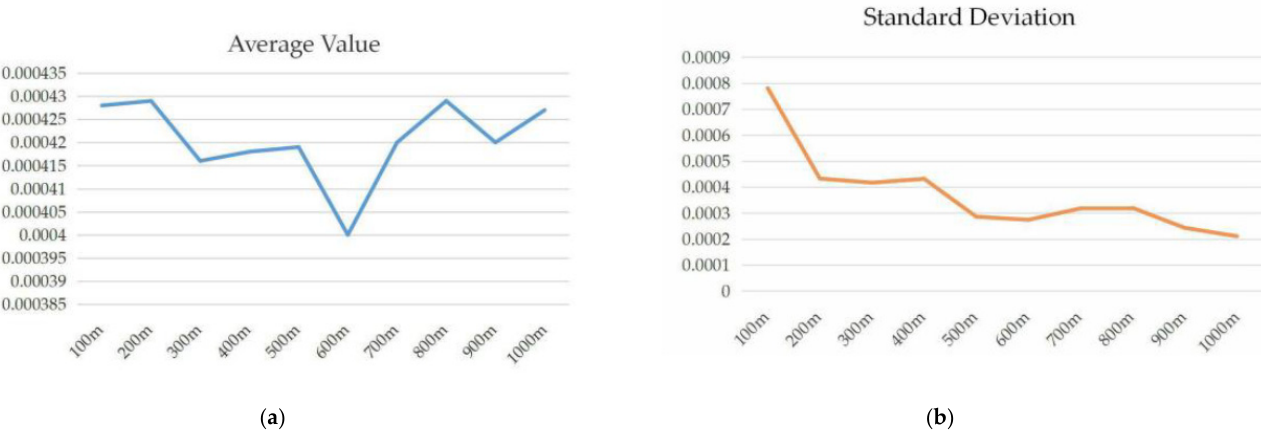
Figure 6. The average density of the POI data and the standard deviation of the average density.